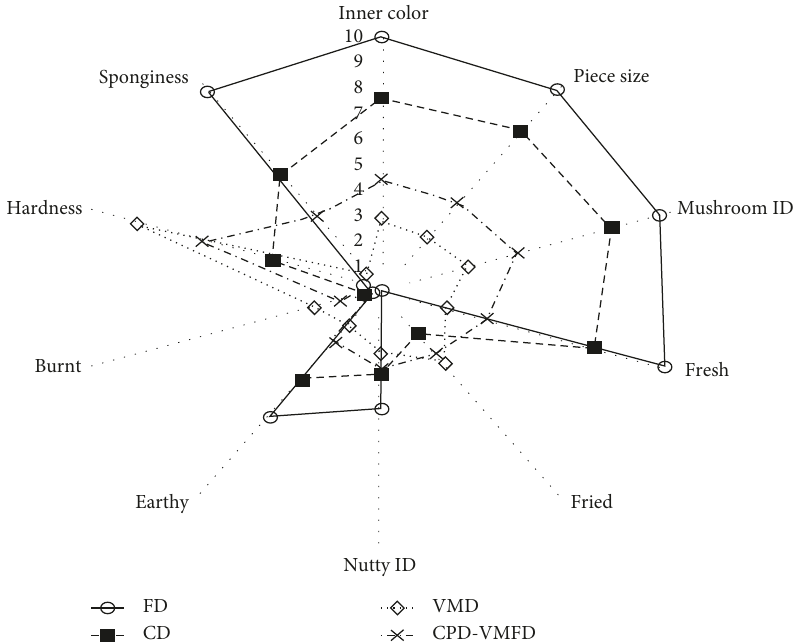
Figure 2: Descriptive sensory profiles of Boletus edulis samples as affected by the drying methods. Values included in this figure represent the mean value for all the conditions assayed for each drying treatment. That is, the mean of FD, 6 temperatures (40, 50, 70, 80, 50/70, and 50/80 ° C) in CD, 3 microwave powers (240, 480, and 480/240 W in VMD), and 2 different temperatures (60 and 70 ° C) in CPD for the combined method CPD-VMFD.